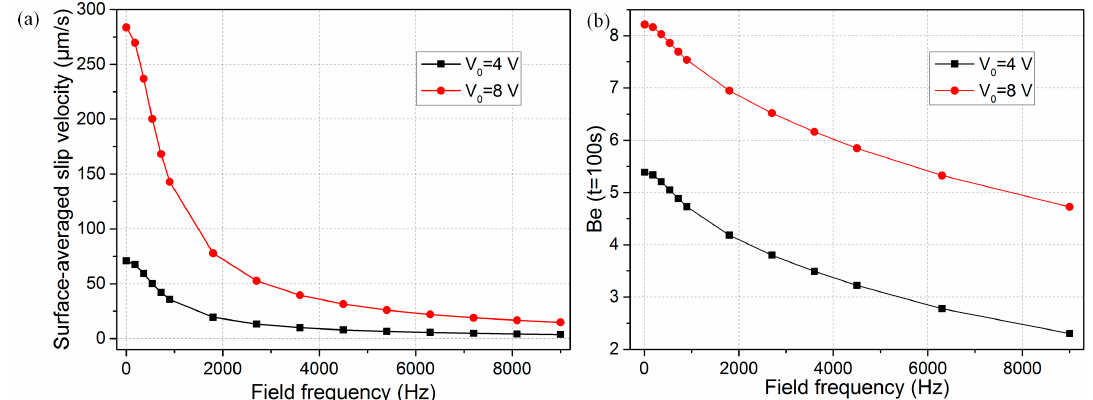
Figure 7. ( a ) Frequency-dependent surface-averaged ICEO slip velocity for different voltage magnitudes when Da is 1000; ( b ) plot of binding enhancement factor versus sinusoidal signals with different field frequencies when the voltage amplitude is 4 V and 8 V, respectively.